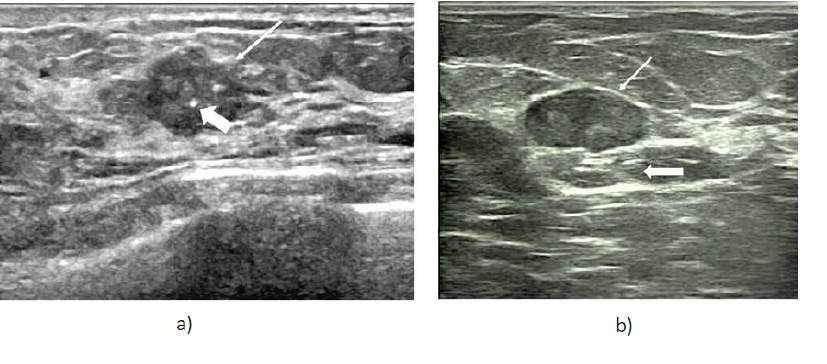
Figure 4. Ultrasound depictions of malignant breast lesions: ( a ) lesion characterized by irregular shape, calcification indicated by large arrow and not circumscribed margin by thin arrow ( b ) lesion characterized by the an oval shape, circumscribed margins indicated by thin arrow and enhancement posterior features by large arrow